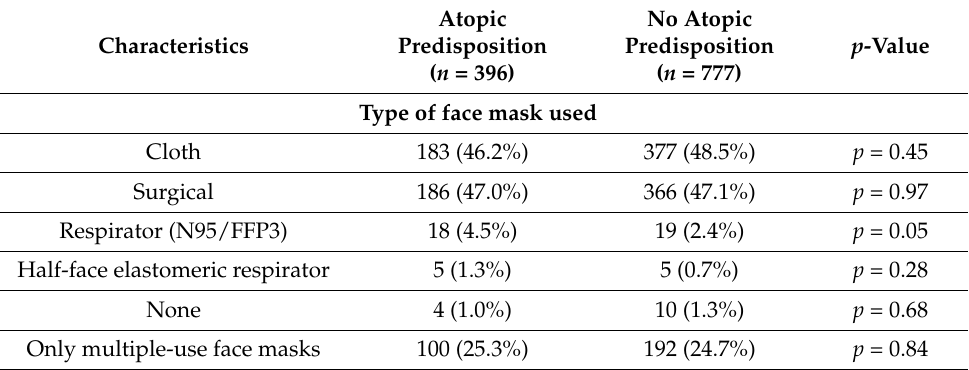
Table 2. The influence of personal atopic predisposition on the type of face mask used and other face mask-related behaviors. The values in bold are considered statistically